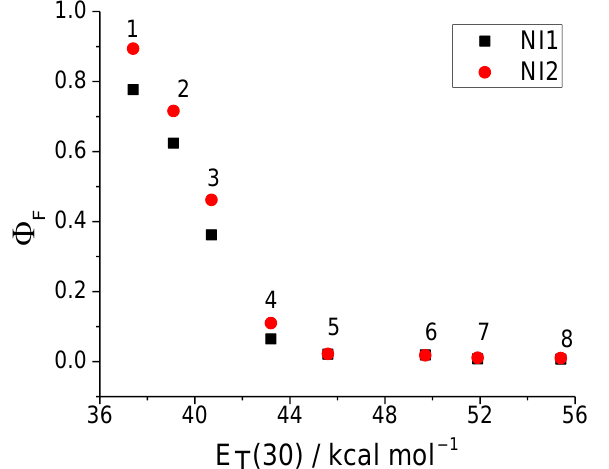
Figure 2. Dependence of quantum yield of NI1 and NI2 on the polarity of organic solvents: (1) tetrahydrofuran, (2) chloroform, (3) dichloromethane, (4) N , N -dimethylformamide, (5) acetonitrile, (6) n -butanol, (7) ethanol, and (8) methanol.